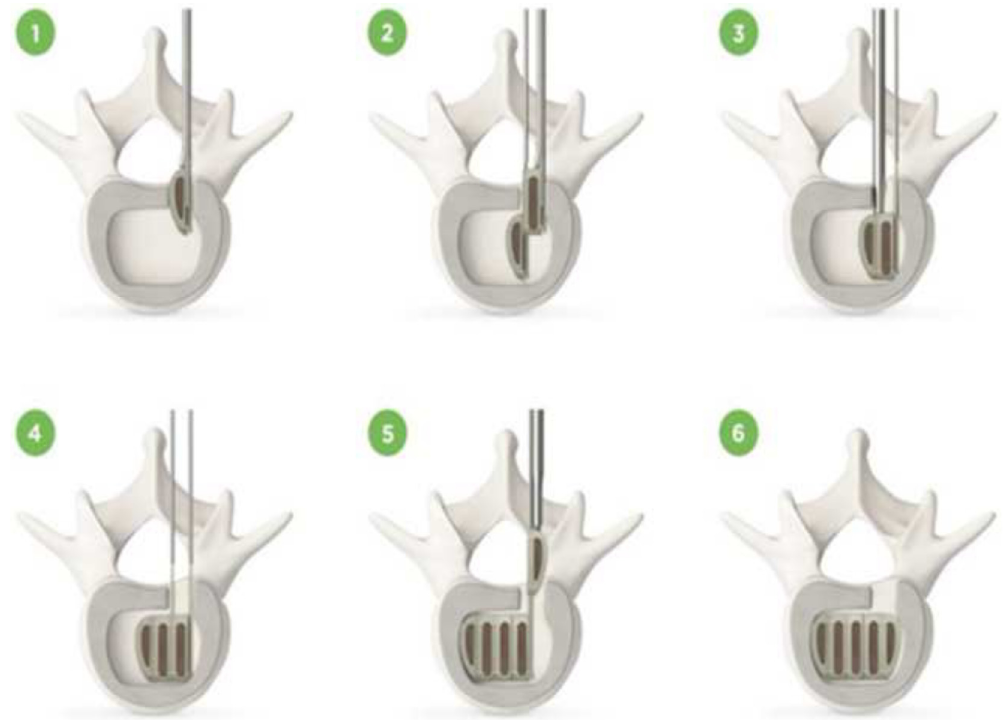
Figure 1. Technique of Interfuse modules assembly within disc